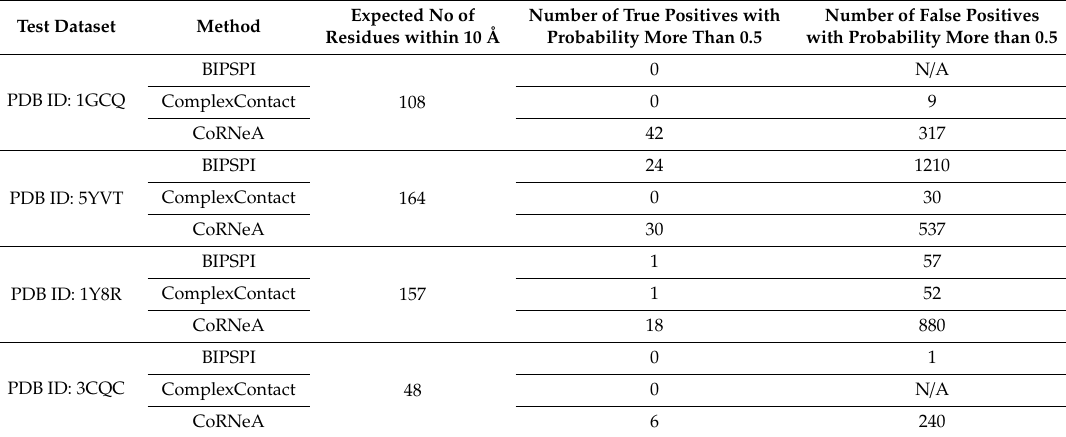
Table 4. Comparison of predictions from CoRNeA with BIPSPI and